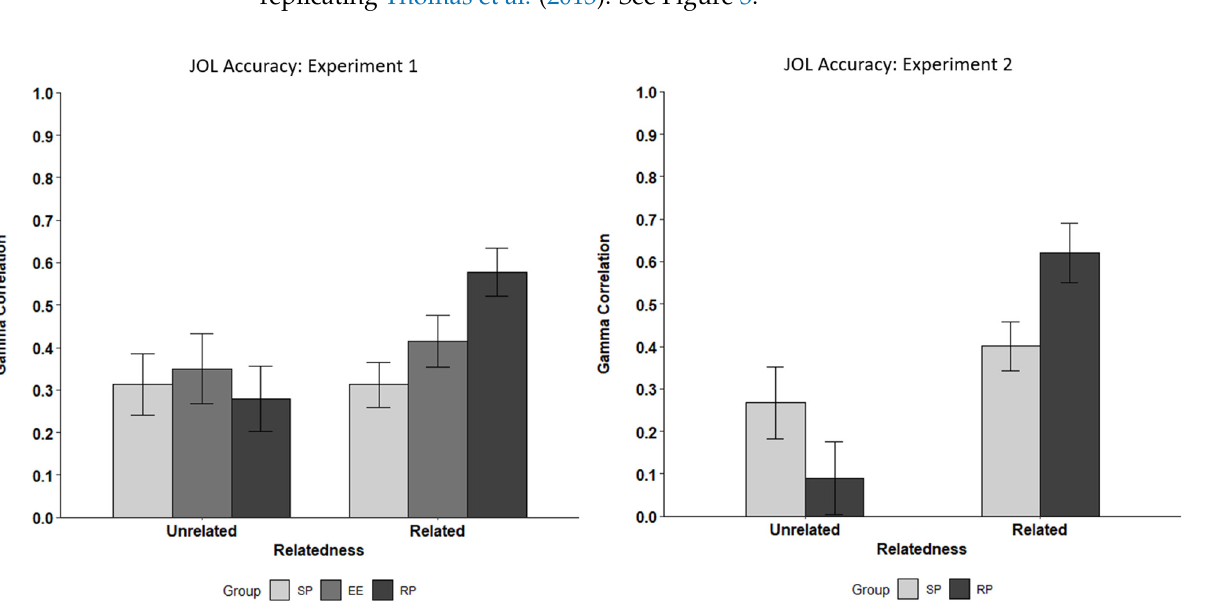
Figure 3. Delayed judgment-of-learning accuracy as a function of study-technique group and item type. SP = study practice; EE = elaborative encoding; RP = retrieval practice. Error bars represent the standard error of the mean.